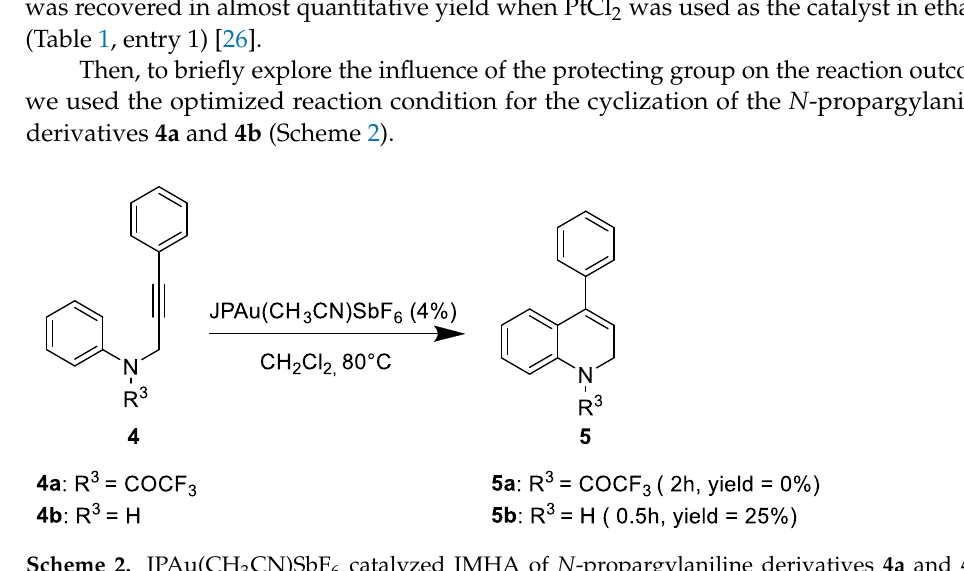
Scheme 2. JPAu(CH 3 CN)SbF 6 catalyzed IMHA of N -propargylaniline derivatives 4a and 4b a .